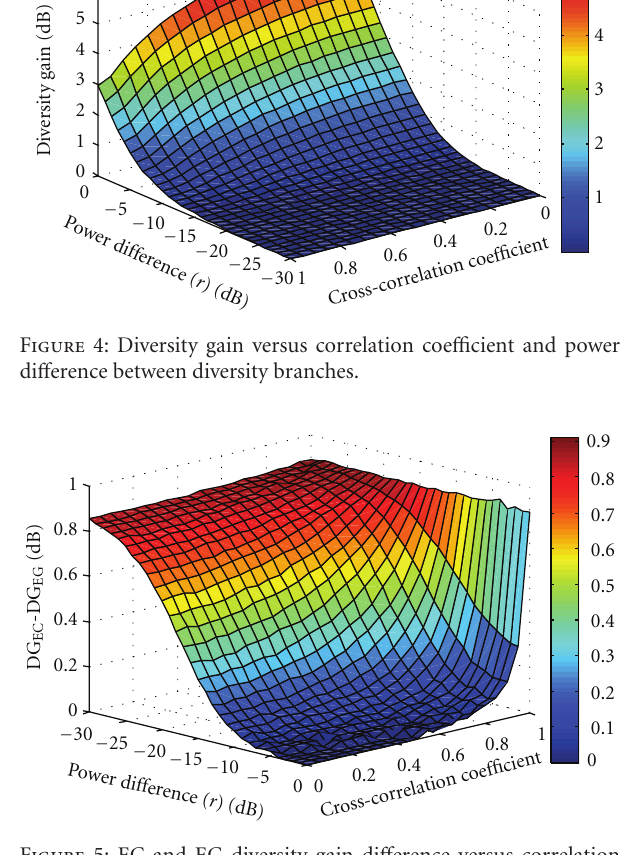
Figure 5: EC and EG diversity gain di ff erence versus correlation coe ffi cient and power di ff erence between diversity